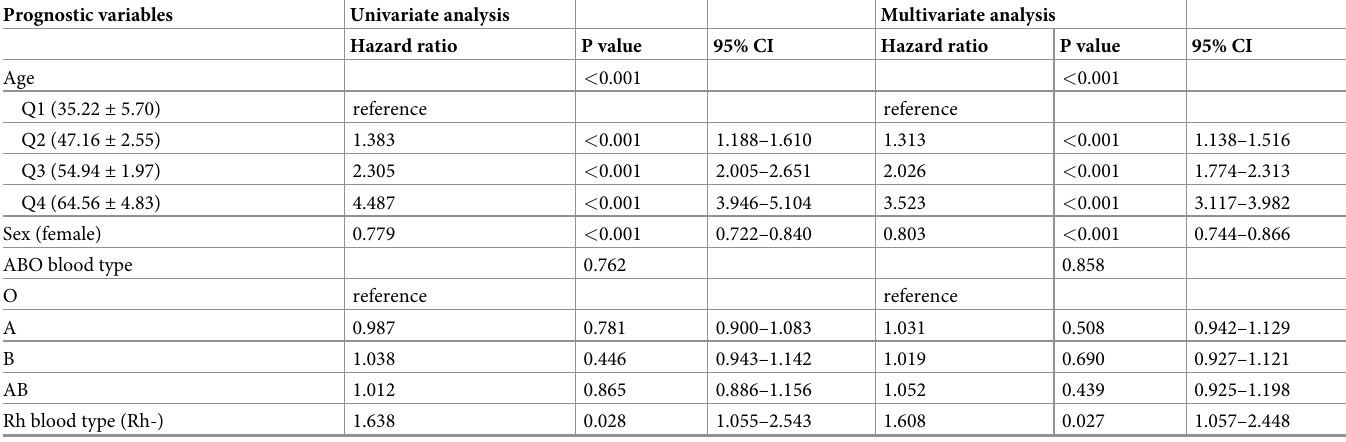
Table 3. Univariate and multivariate regression analyses of death during waiting time before transplantation on the waiting